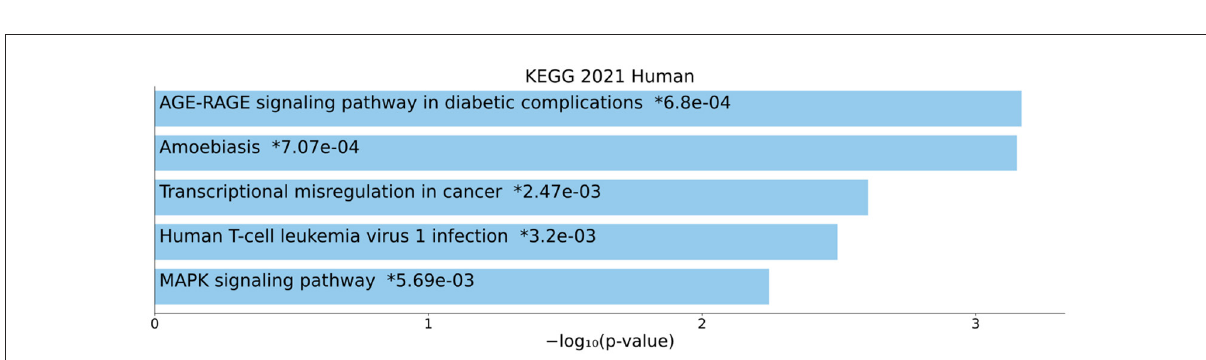
FIGURE5 Kyoto Encyclopedia of Genes and Genomes (KEGG) pathway enrichment analysis. The top five enriched pathways are displayed along with the corresponding P -values in a bar graph. Those with significant P -values (i.e., < 0.05) are matched with the colored bars. A P -value (shown with *) shows the significant adjusted P -value ( <